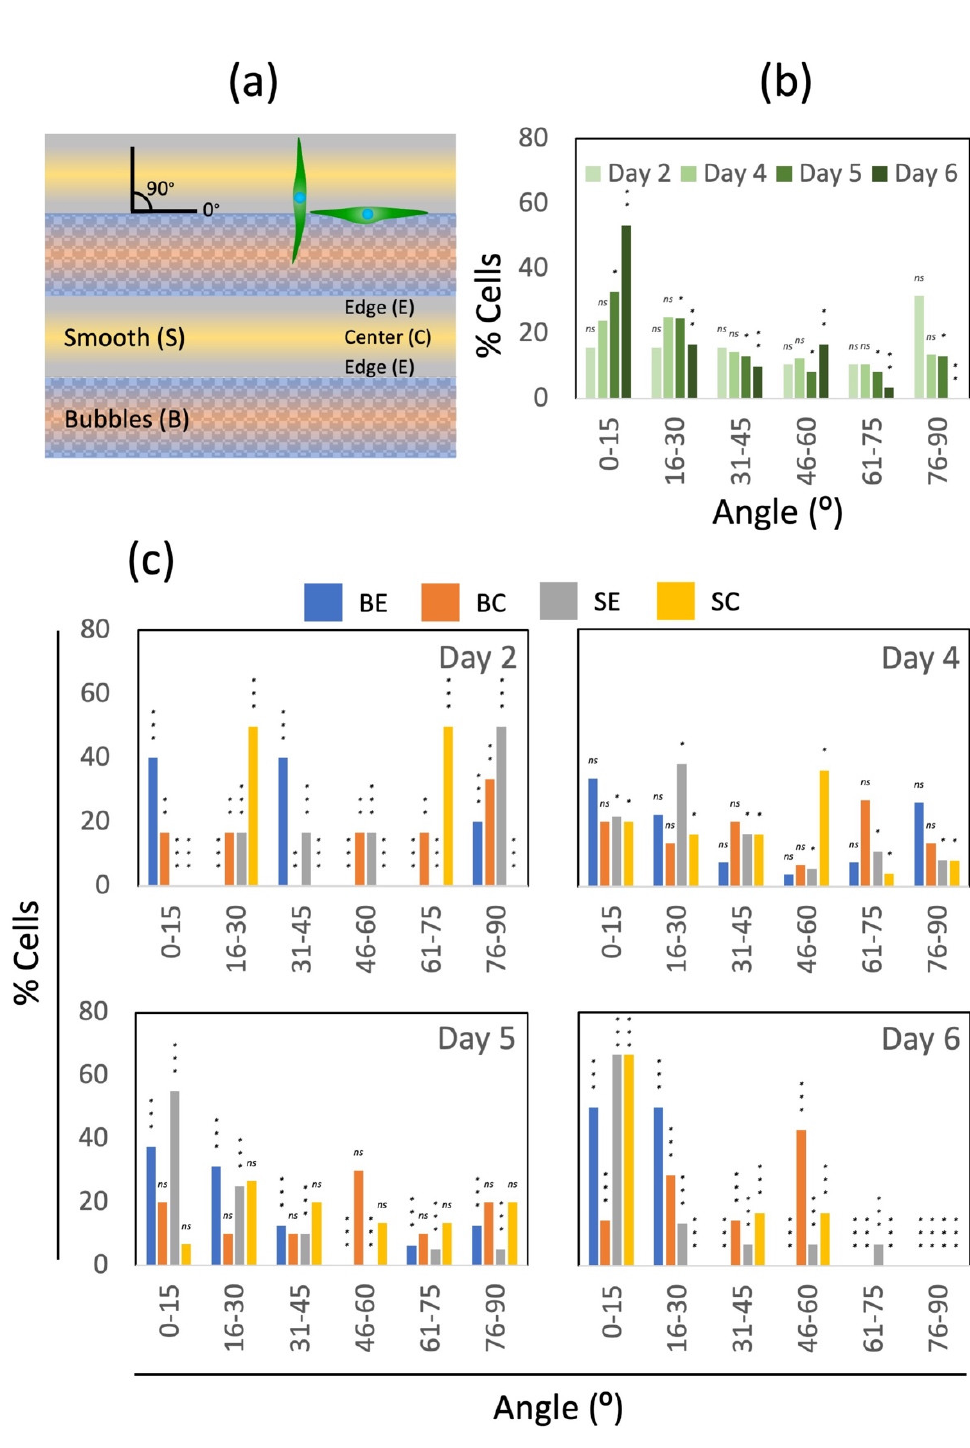
Figure 7. Effect of foamed patterns on cell orientation. Schematic representation of the degree of cell alignment, with respect to printed arrays, within four different zones in the PLA films ( a ). Evolution of the cell angles, with respect to the printed arrays over time, ( b ) within the entire PLA surface and ( c ) within the different surface zones. A Chi-squared statistical test was used to determine the statistical significance of the difference of distribution of cell angles, with respect to a homogeneous distribution. NS indicates no significant difference. Symbols *, **, and *** indicate statistical significance at p < 0.05, p < 0.001, and p < 0.0001, respectively.